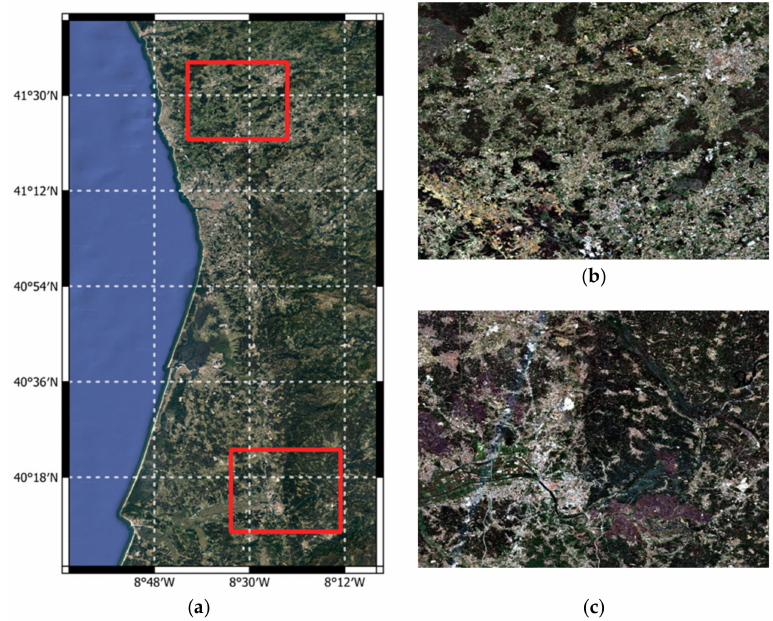
Figure 11. Portugal test sites. ( a ) Used polygons around the cities of Braga (top rectangle) and Coimbra (bottom rectangle) with a Google Earth background. ( b ) S2 image of the Braga site. ( c ) S2 image of the Coimbra